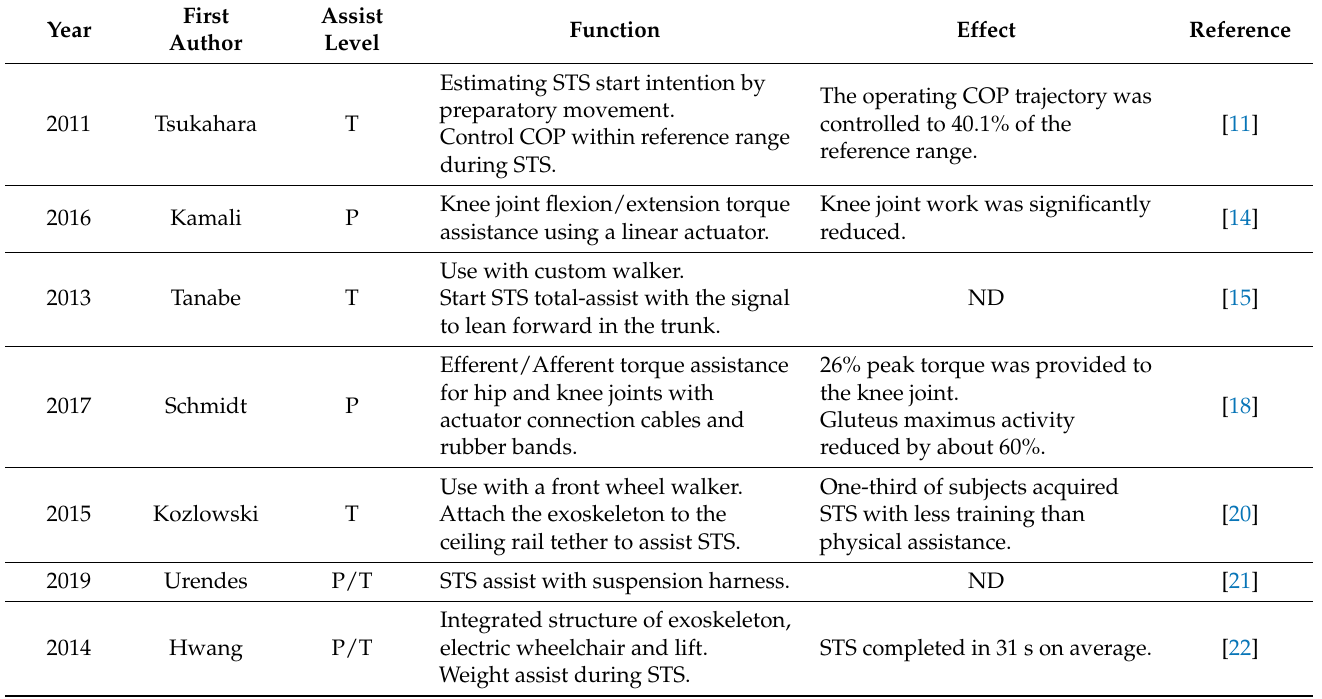
Table 1. Assist functions and effects (Wearable